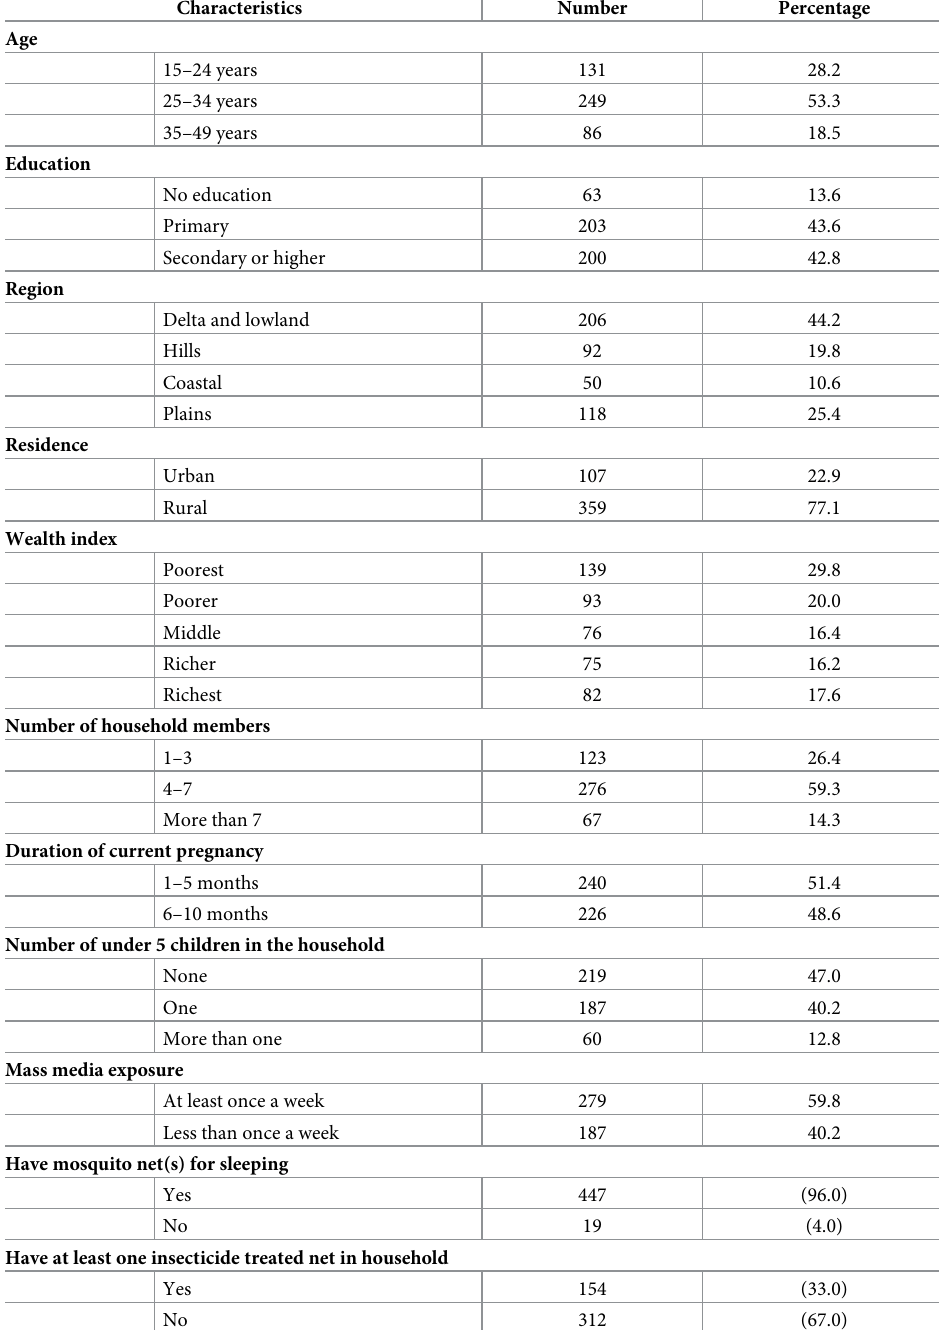
Table 1. Background characteristics of currently pregnant women included in the Myanmar Demographic and Health Survey 2015–16 (n =